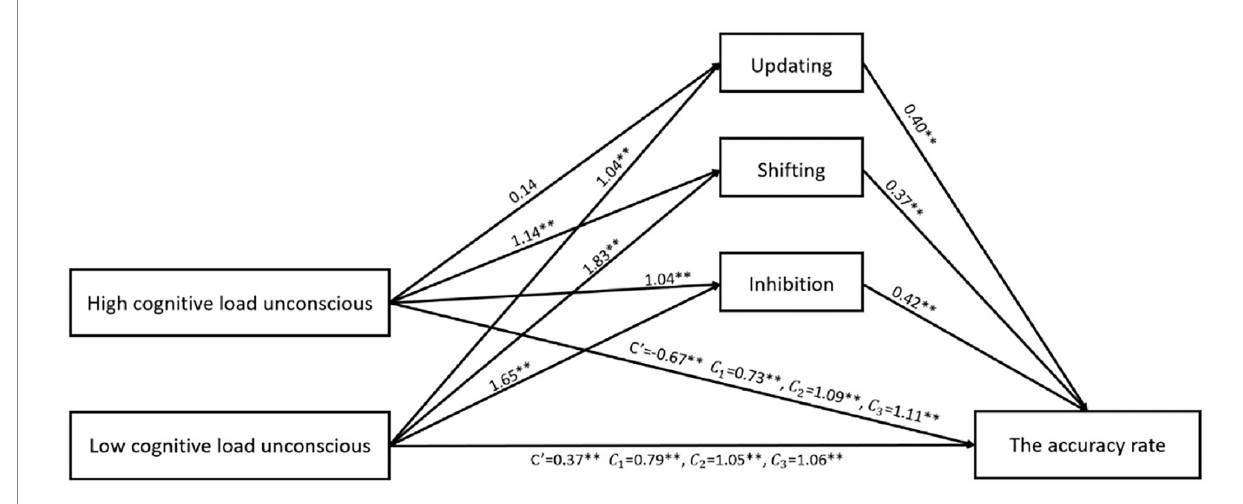
FIGURE 6 Mediation analysis with an accuracy rate as the dependent variable. ** indicates that the correlation is significant at the level of